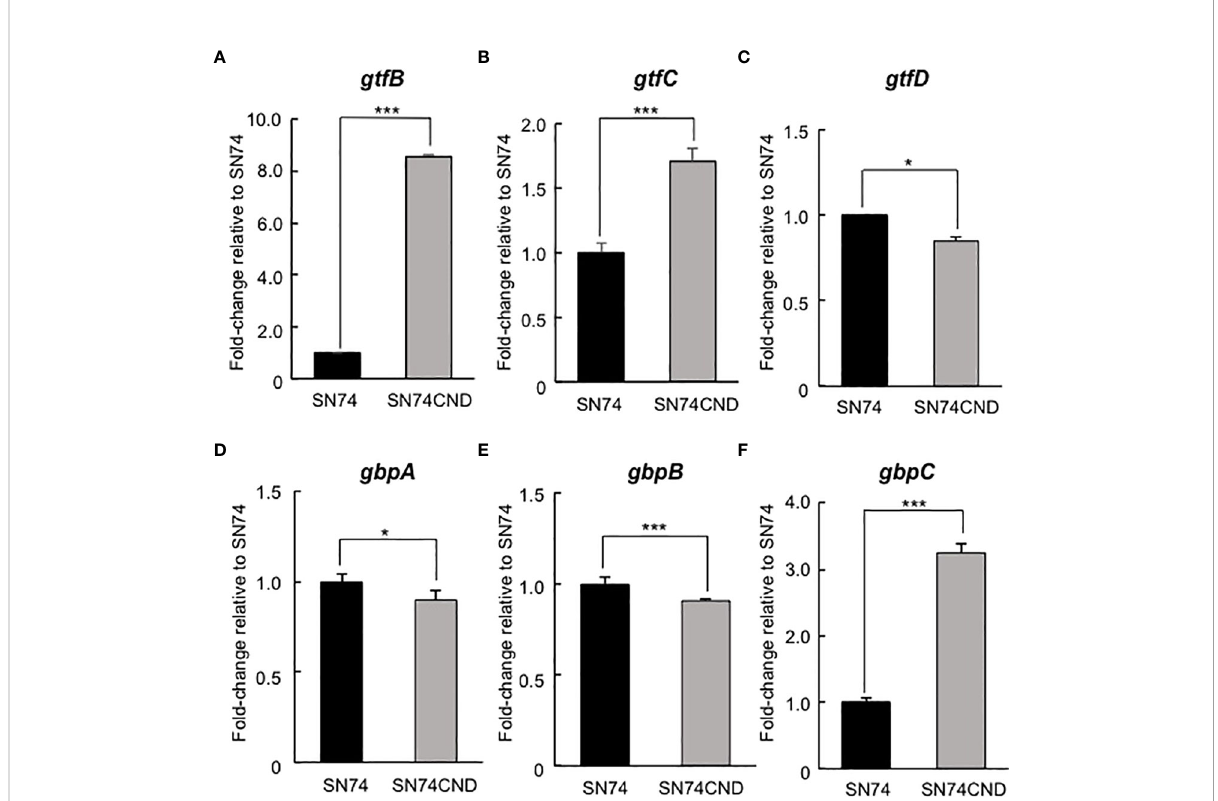
FIGURE 5 Comparison of gene expression levels in strains SN74 and SN74CND by real-time quantitative reverase transcription PCR. (A) gtfB , (B) gtfC , (C) gtfD , (D) gbpA , (E) gbpB , (F) gbpC . The mRNA expression values were quanti fi ed by the DD CT method using 16s rRNA as the internal control. Data are presented as the mean ± SD from fi ve independent experiments. Statistical signi fi cance was determined using analysis of variance with the Mann-Whitney U test. * P < 0.05, *** P <